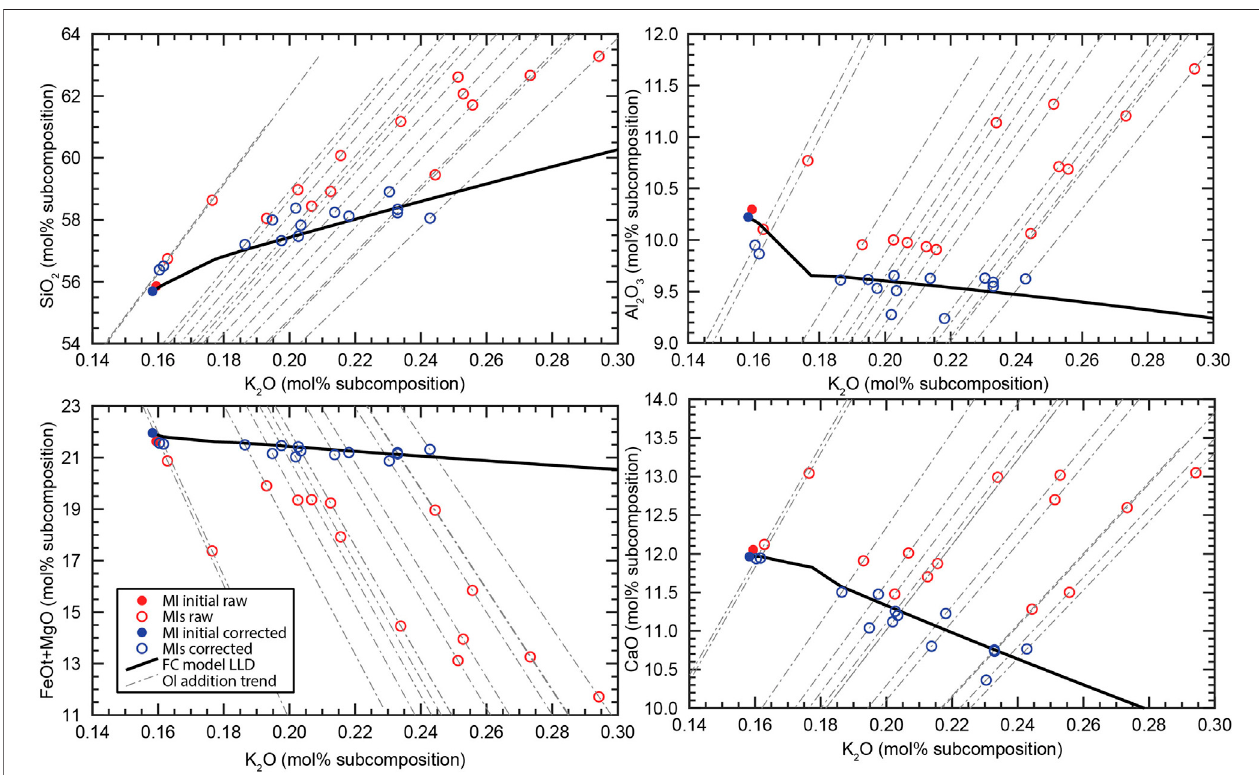
FIGURE 2| Variation diagrams (in mol%) as an example of potential PEC correction for one FC simulation. Componentsare re-normalized to the sub-composition de fi nedbySiO 2 ,Al 2 O 3 ,FeOt+MgO,CaOandK 2 O.RedcirclesrepresenttherawMIcompositions,andbluecirclesarethePECcorrectedMIcompositions.Filledcircles indicate the composition of the MI used as initial composition of the FC model. Dashed grey lines indicates the trend of olivine addition-subtraction, and the black line is theLLDofoneoftheFCsimulationsgeneratedintherhyolite-MELTSiterations.Thecorrectedcompositionscorrespondtotheclosestpointofeacholivineaddition trend to the FC model LLD, which is measured as the smallest Aitchison distance between the two compositional trends.